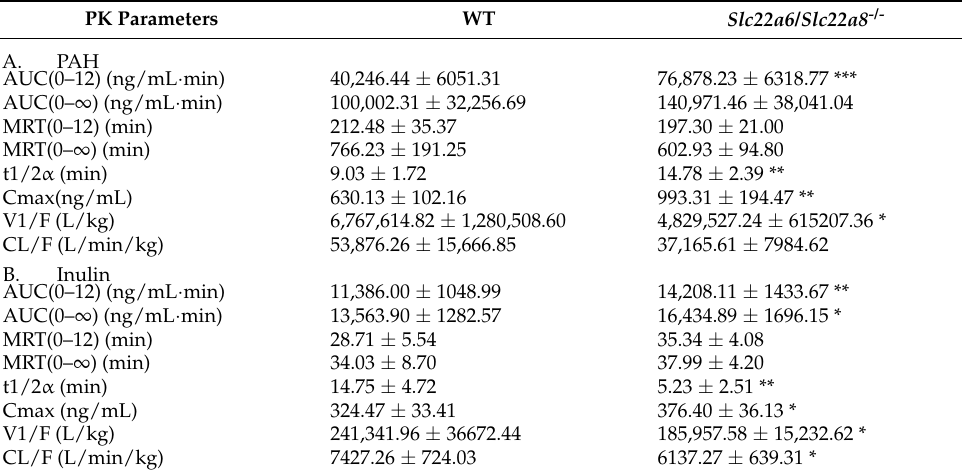
Figure 6. Effects of Slc22a6 / Slc22a8 double-knockout on the pharmacokinetics and urinary excre- tions of substrate of OAT1/OAT3 and inulin. ( A ) Plasma concentration-time curve of PAH (n = 5). ( B ) Plasma concentration-time curve of inulin (n = 5). ( C ) Cumulative urinary excretion-time curve of PAH (n = 6). ( D ) Cumulative urinary excretion–time curve of inulin (n = 6). Data are presented as mean ± SD. *, p < 0.05; **, p < 0.01; ***, p < 0.001 compared with WT rats. Table 2. Pharmacokinetic parameters of PAH and inulin after intravenous injection in